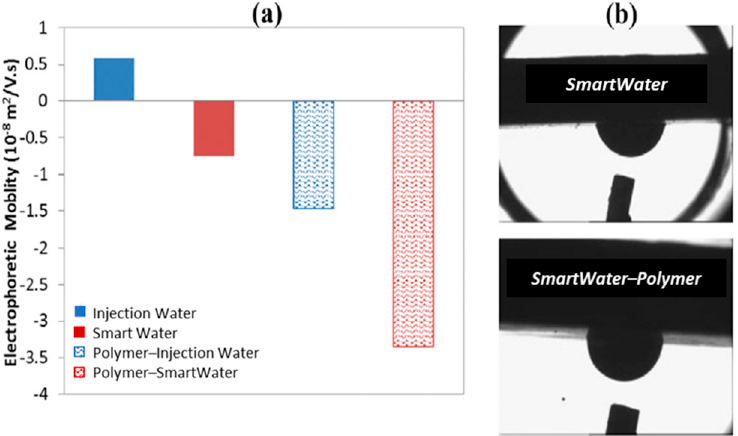
Figure 15. ( a ) A higher reduction in the zeta potential and ( b ) an increased wettability shift to water-wetness in the presence of HPAM polymer in smart water [180].